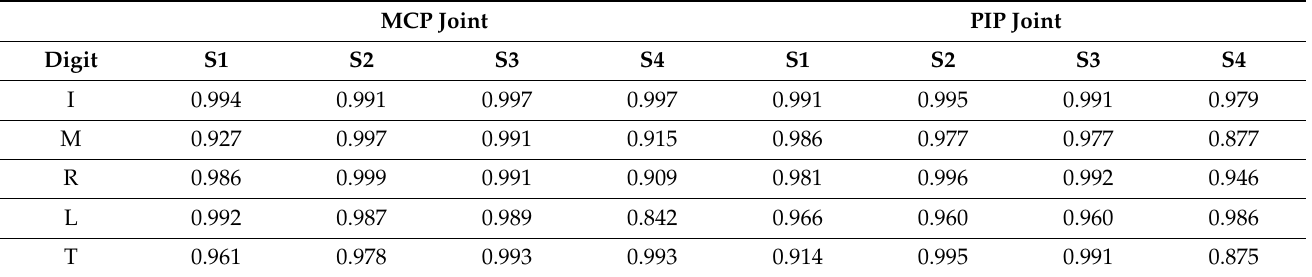
Table 5. Pearson’s correlation showing comparison of goniometric values versus NN-generated angles from data glove.